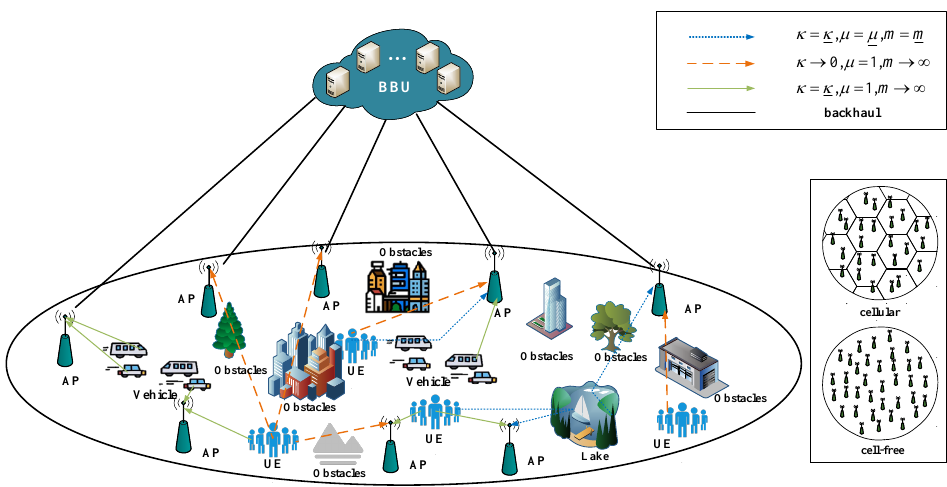
Figure 1. CF mMIMO system under the κ – µ shadowed fading